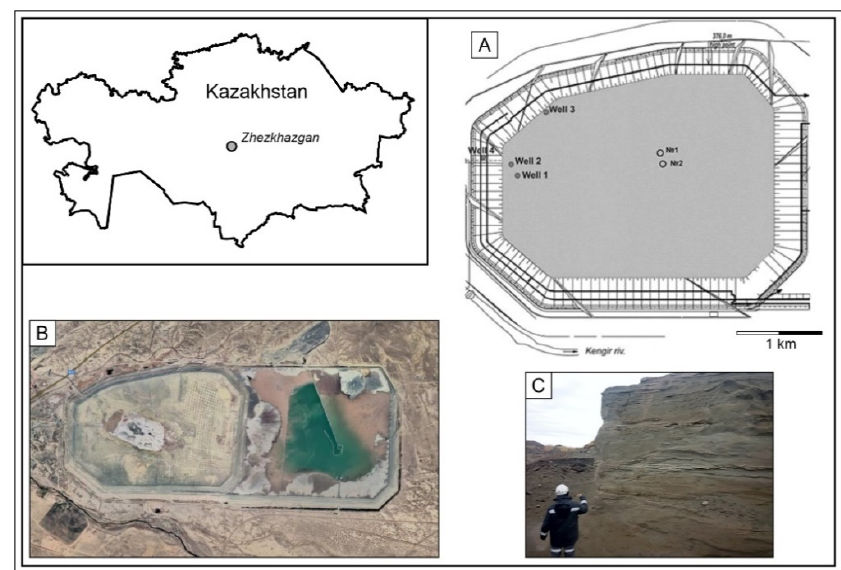
Figure 3. Zhezkazgan location, ( A ) drill hole location and sampling scheme in Osnovnoe (OS) tailing, ( B ) Osnovnoe (OS) location, according to Google Maps (accessed 27 May 2021), ( C ) photograph of sampling of the Osnovnoe (OS) indicating interbedded fine silts and coarse sands.